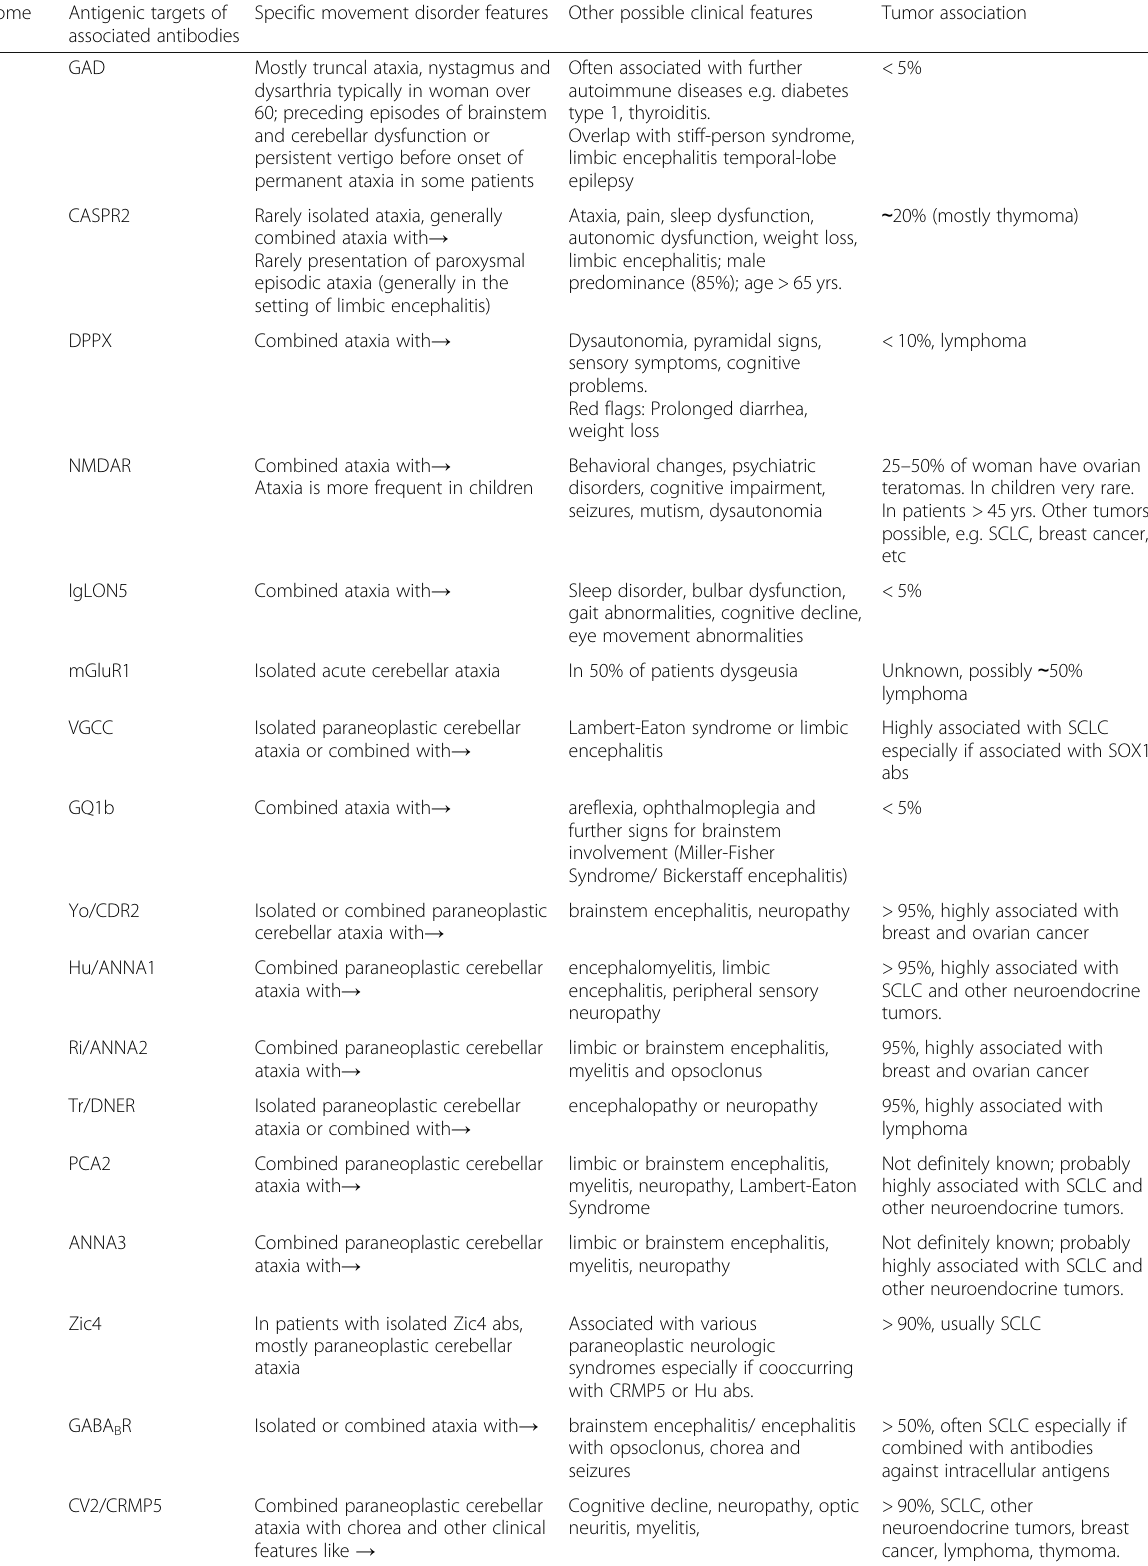
Table 1 Antibody-related movement disorders: Clinical features and tumor association